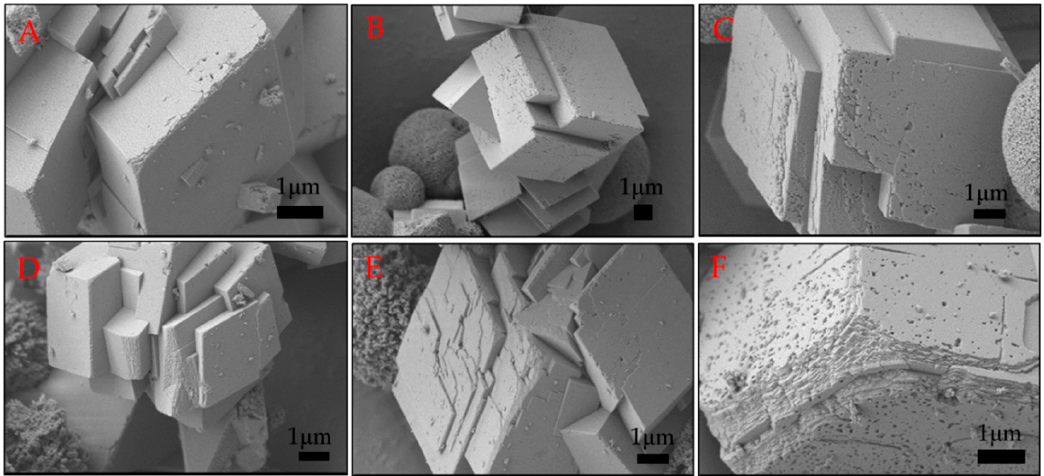
Figure 6. SEM images of calcium carbonate precipitated in 10 ppm of surfactin. ( A–C ) 30 min of aging, ( D ) 1 h of aging, ( E ) 3 h of aging, ( F ) 24 h of aging. The concentration of CaCl 2 and Na 2 CO 3 was 5 mM. Table 5. Phase composition of precipitated calcium carbonate calculated from the di ff raction patterns. (Standard deviation for calcite / vaterite content was lower than 1%). Surfactin concentration was 10 ppm. pH was 8.